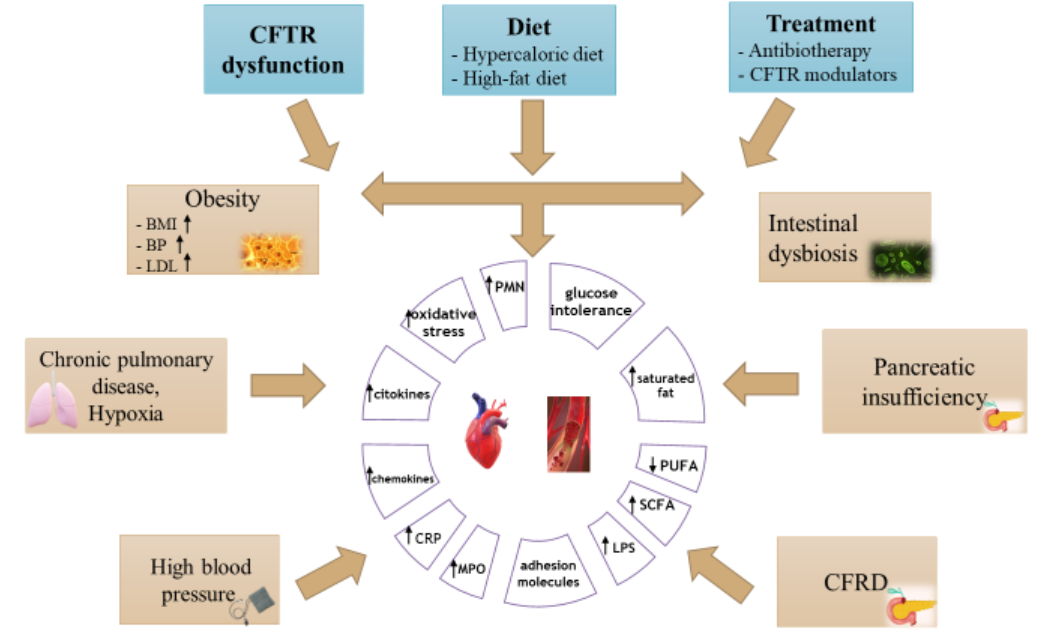
Figure 1. The pathogenesis of cardiovascular disease in cystic fibrosis (BMI — body mass index, BP — blood pressure, LDLc — low-density lipoprotein cholesterol, CRP — C-reactive protein, MPO — myeloperoxidase, LPS — lipopolysaccharides, SCFA — short-chain fatty acids, PUFA — polyunsaturated fatty acids, PMN — polymorphonuclear cells).